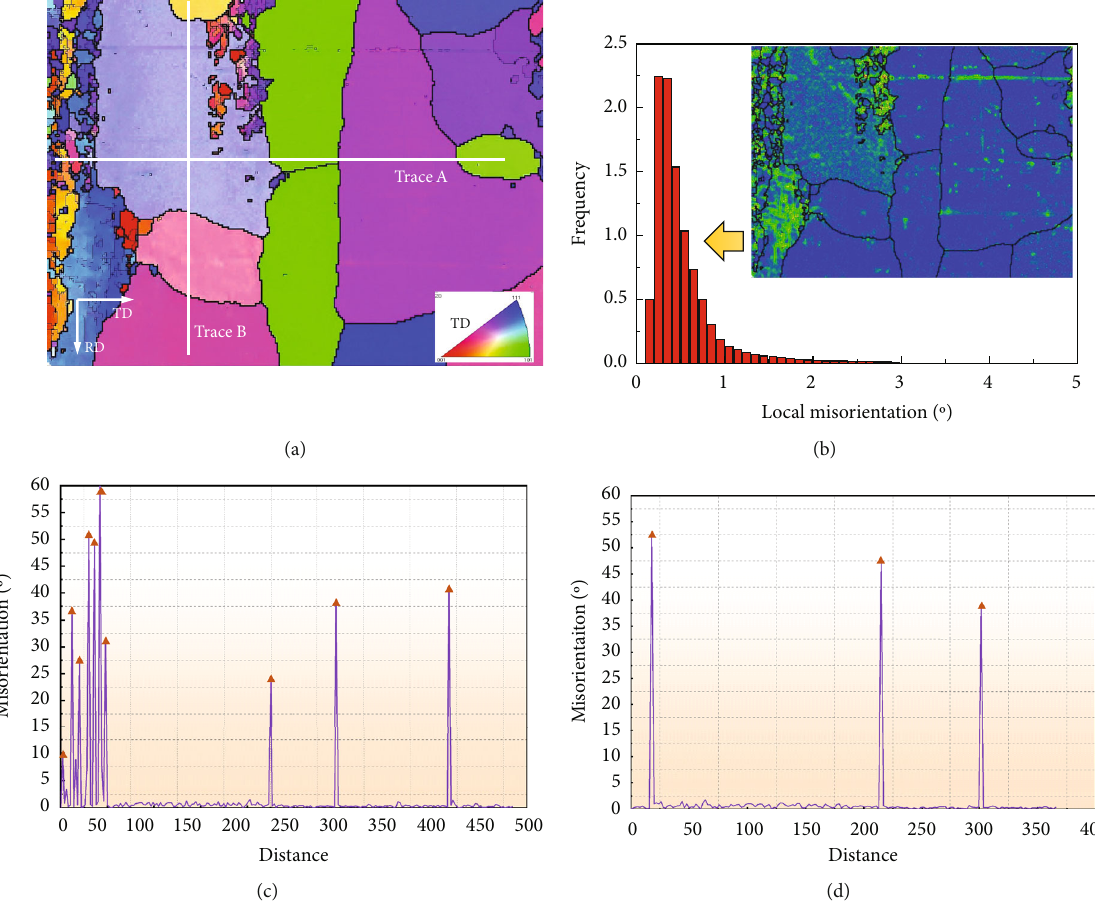
Figure 5: (a) IPF of the alloy; (b) local misorientation distribution; (c, d) misorientation distribution along trace A and B in (a),